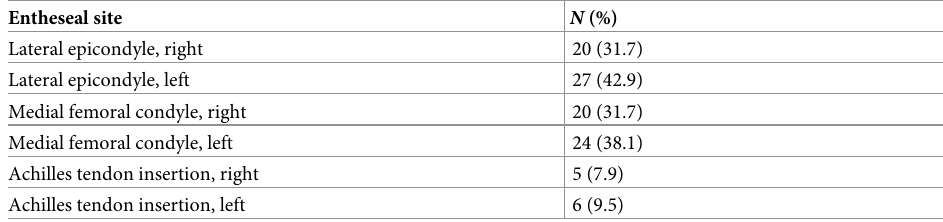
Table 3. The distribution of entheseal sites as assessed using the Leeds enthesitis index (LEI) at the first assess- ment by a rheumatologist (n = 63). Entheseal